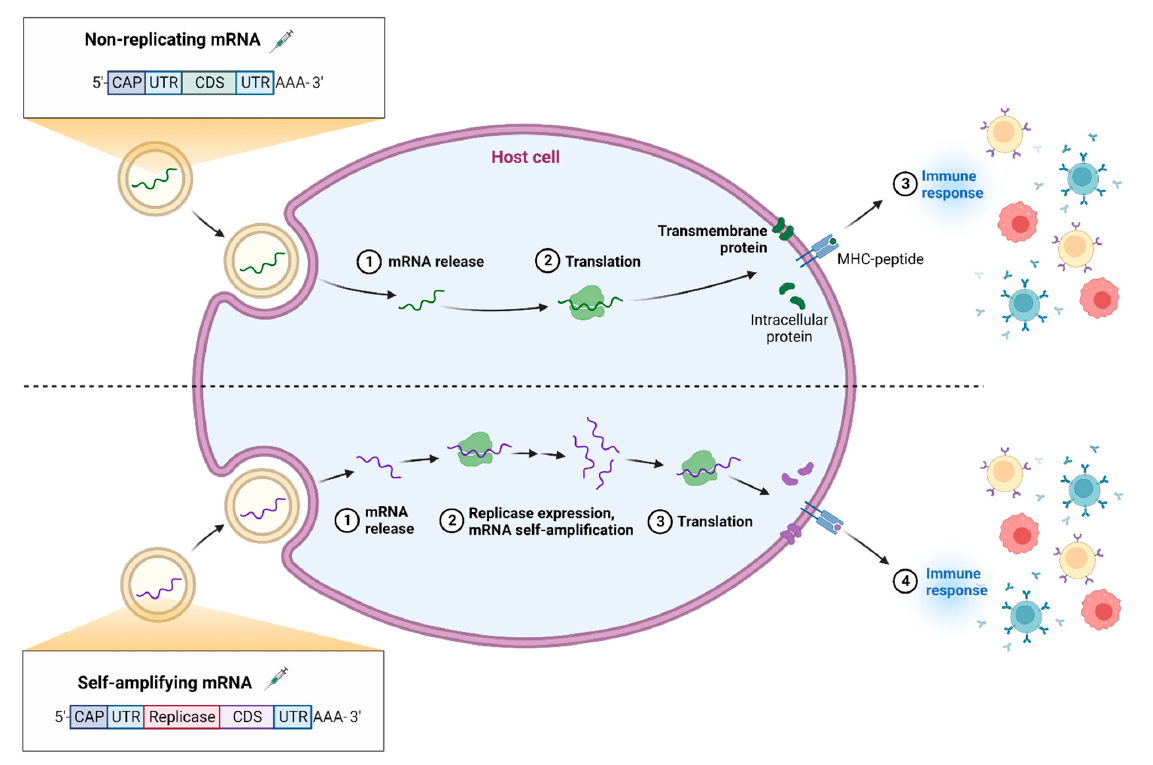
Figure 4. Categories of mRNA. (Created with BioRender.com accessed on 31 December 2022).